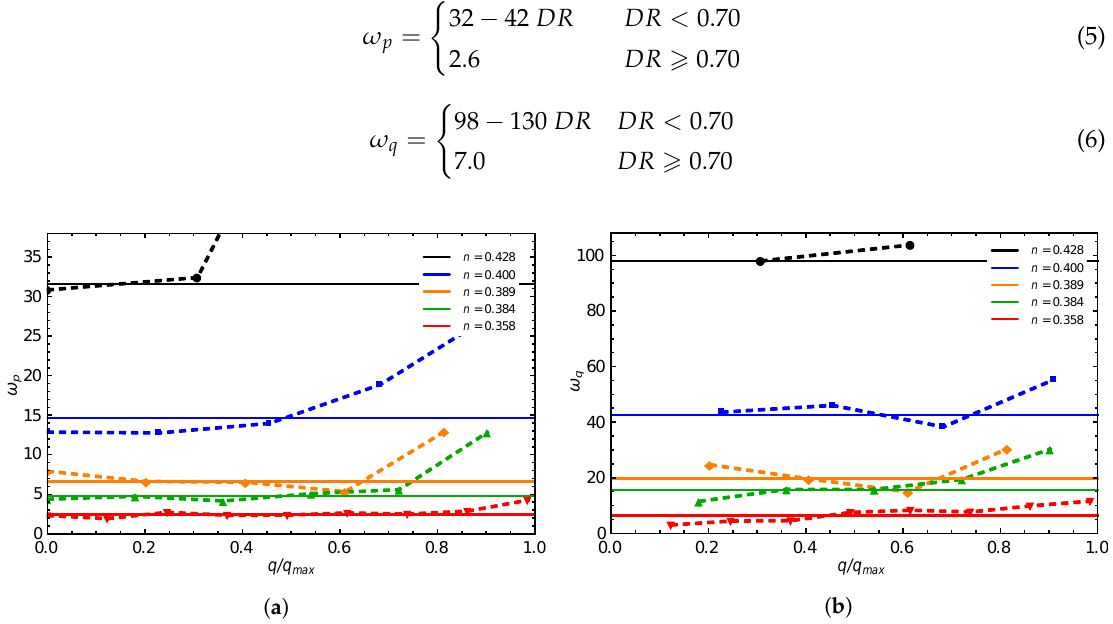
Figure 4. Spherical and deviatoric stress relaxation as a function of mobilized strength: ( a ) values of ω p as a function of q / q max ; ( b ) values of ω q as a function of q / q max . Colors represent different porosities (dots = DEM results linked by dashed lines, continuous line = fitted constant values).